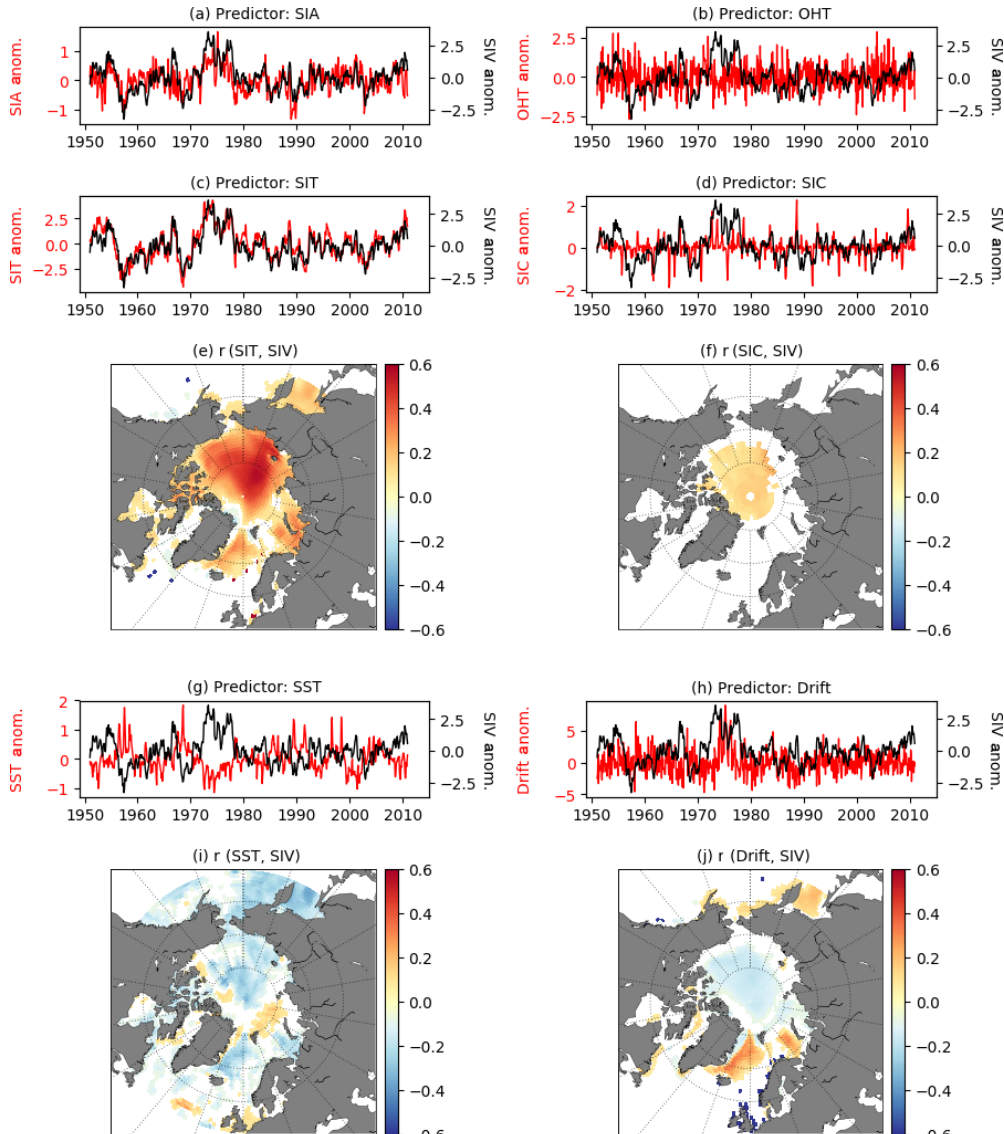
Figure 2. Lag-0 comparison between the time series from the predictand (SIV (10 3 km 3 ); black lines) and predictors: (a) SIA (10 6 km 2 ), (b) OHT (PW), (c) SIT (m), (d) SIC (%), (g) SST ( ◦ C), and (h) Drift (kmd − 1 ) (red lines). The correlation maps used for normalizing the regional predictors, as suggested by Drobot et al. (2006), are also shown: (e) SIT, (f) SIC, (i) SST, and (j) Drift. Here, AWI-LR is merely used as an example case and not for a specific